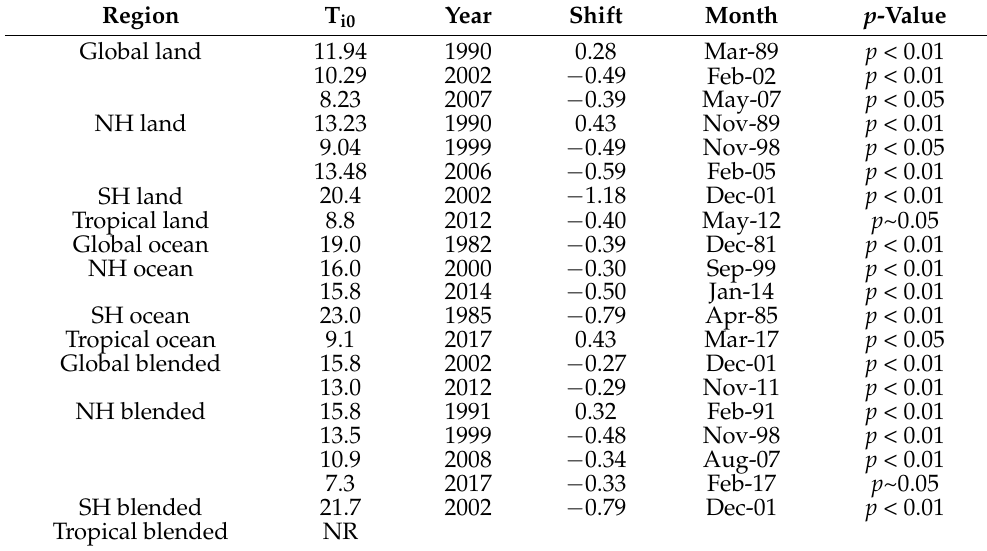
Table 2. Bivariate test result (T i0 ), year of shift, month of shift, p -value for regime changes in relative humidity (%) from HadISDH